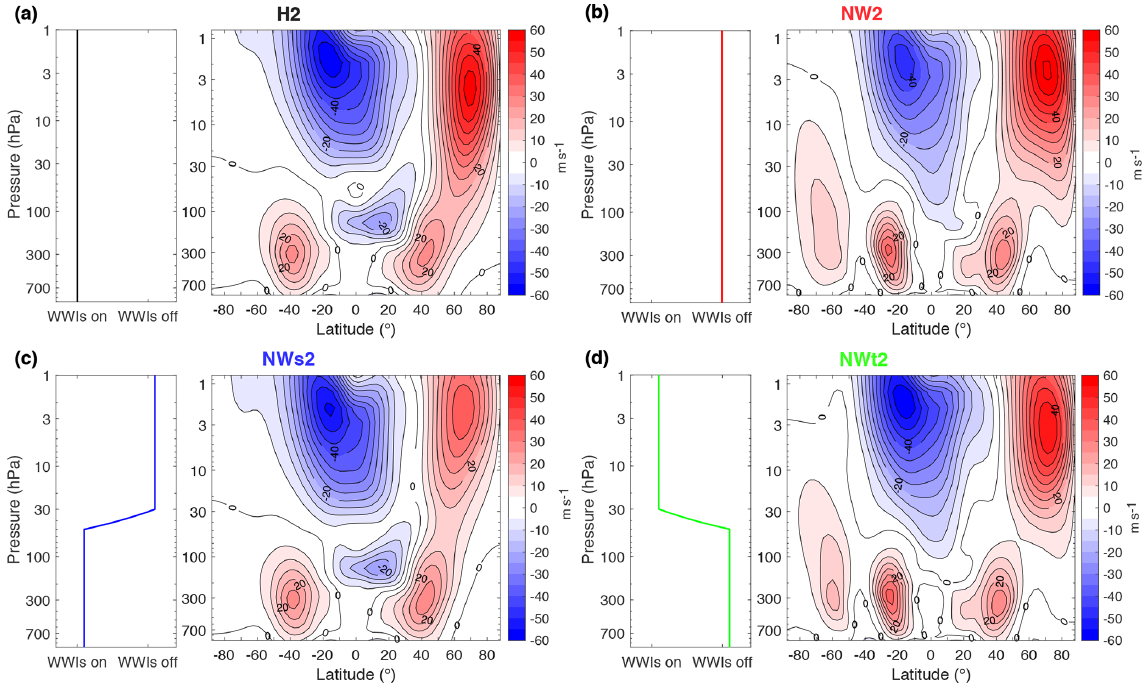
Figure 2. Zonal-mean zonal winds for H2 (a) , NW2 (b) , NWs2 (c) and NWt2 (d) , with panels showing the pressure levels where WWIs are allowed. The contour interval is 5ms − 1